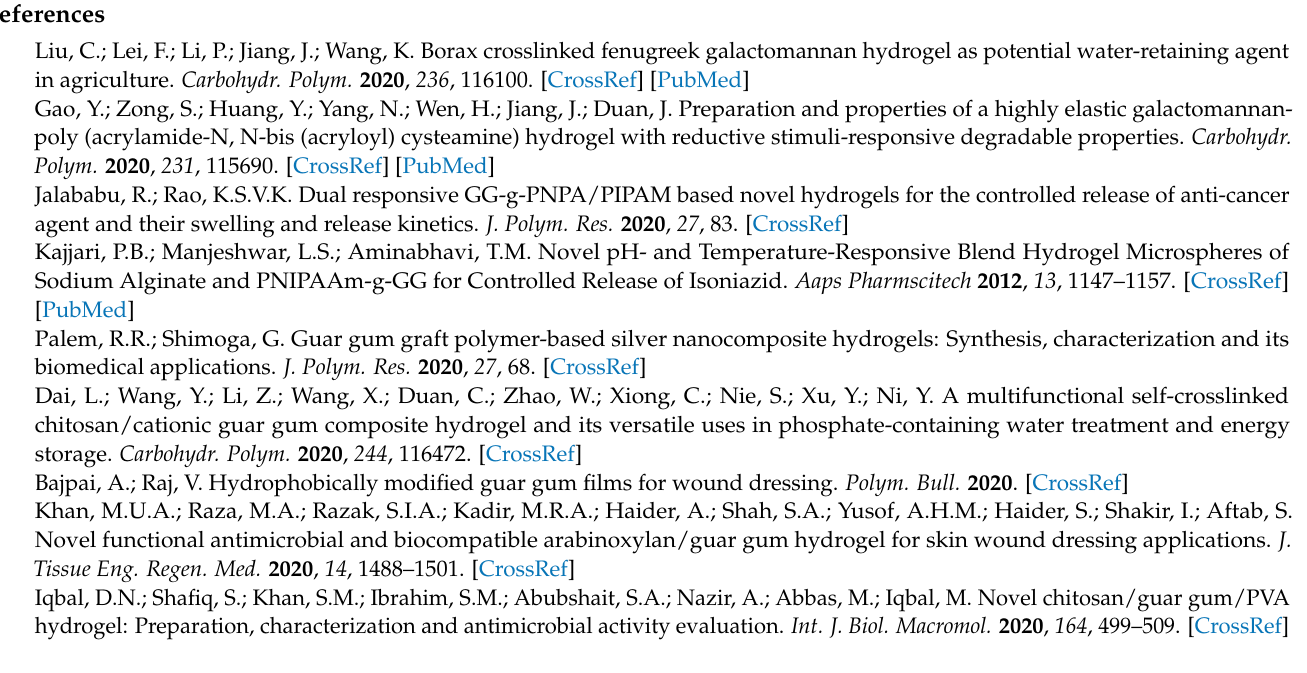
60 ◦ C; (c) 50 ◦ C; (d) 50 ◦ C; (e) 40 ◦ C; (f) 40 ◦ C; (g) 30 ◦ C; (h) 30 ◦ C; (i) 20 ◦ C; (j) 20 ◦ C), Figure S5: GA-P (NIPAM-DMAPMA) hydrogels with different crosslinking agent content ((a) Swelling kinetic curve; (b) Equilibrium swelling ratio; (c) Fitting curve of kinetic equation of first-order kinetics; (d) second-order kinetics; (e) Relation between swelling rate and t0.5; (f) ln(Wt/W ∞ )~ lnt relationship), Figure S6: GA-P (NIPAM-DMAPMA) hydrogels with different initiator (APS) content((a) Swelling kinetic curve; (b) Equilibrium swelling ratio; (c) Fitting curve of kinetic equation of first-order kinetics; (d) second-order kinetics; (e) Relation between swelling rate and t0.5; (f) ln(Wt/W ∞ )~ lnt relationship), Table S1: The equilibrium swelling ratio (ESR) of GG-PNIPAM composite hydrogel at different temperatures, Table S2: The first-order kinetic model parameters of the GA–P(NIPAM-co- DMAPMA) hydrogels with different monomer contents, Table S3: The second-order kinetic model parameters of the GA–P(NIPAM-co-DMAPMA) hydrogels with different monomer contents, Table